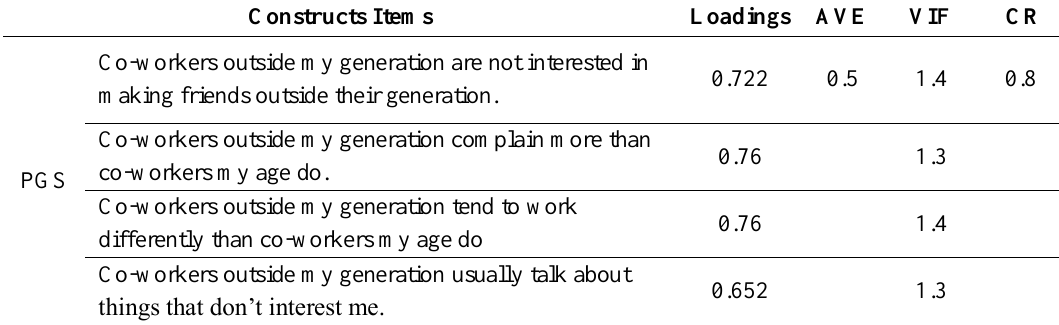
Table.2. Constructs’ Validity &